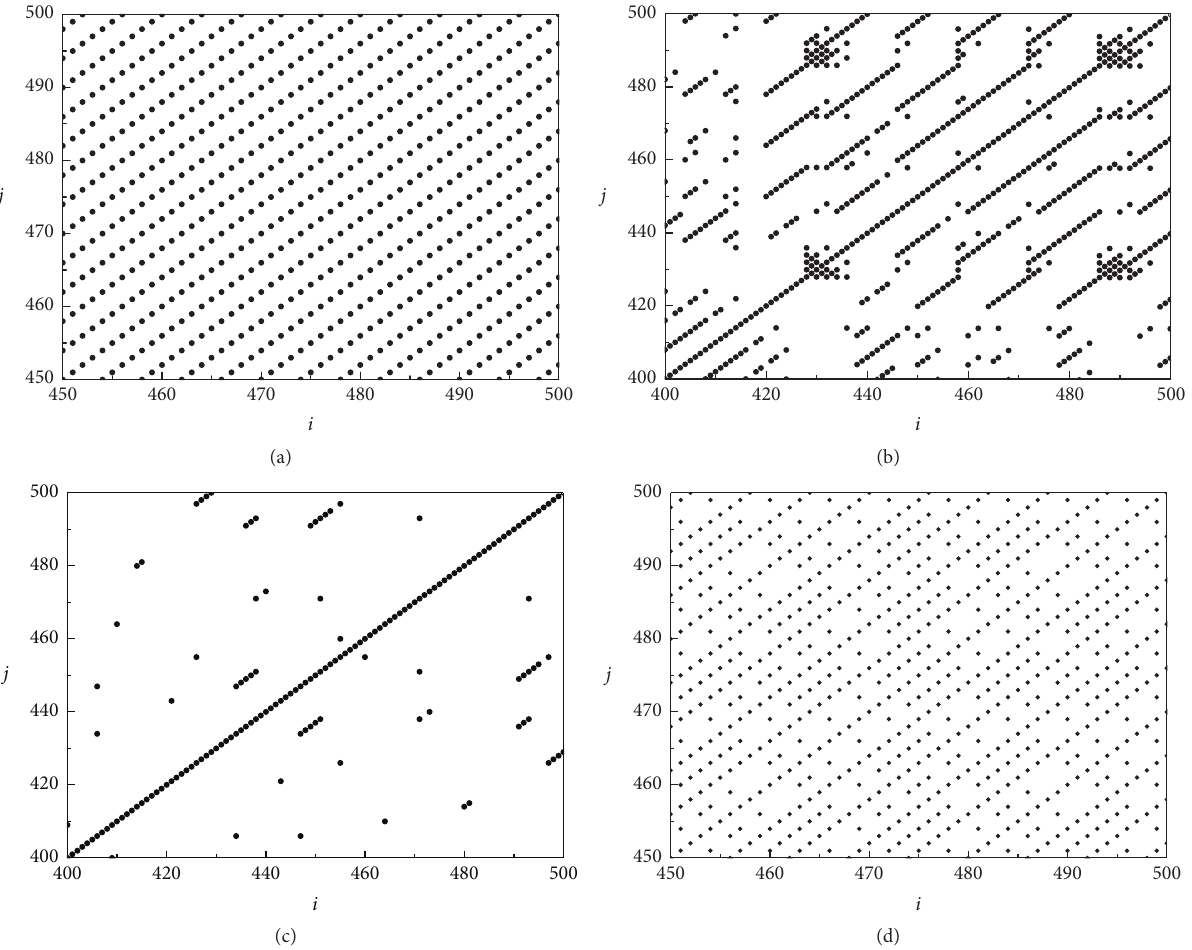
Figure 2: Recurrence plots corresponding to logical models with different parameters: (a) 𝑢 = 3.5 ; (b) 𝑢 = 3.6 ; (c) 𝑢 = 3.8 ; (d) 𝑢 = 3.85 .